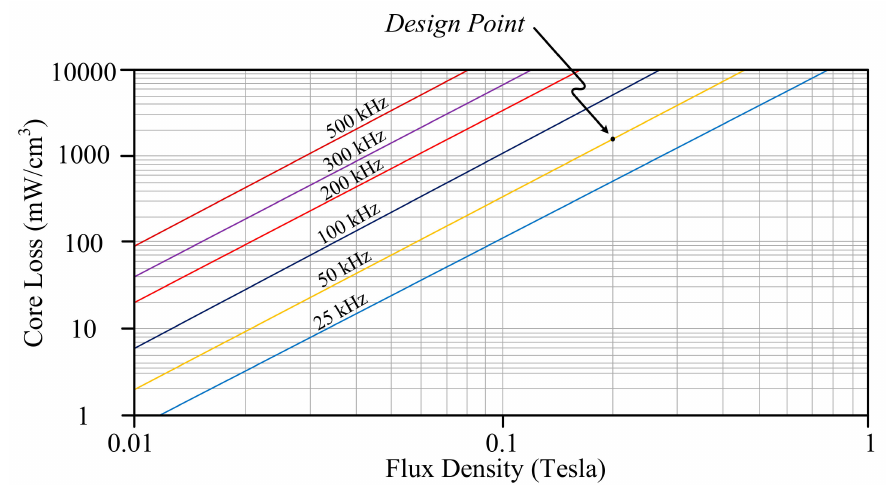
Figure 6. The relationship between core loss and flux density of Kool M µ , while permeability equals 125 µ